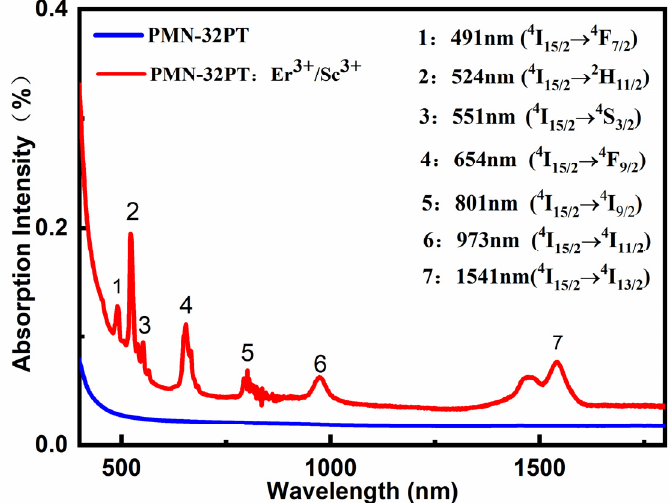
Figure 4. The absorption spectra of PMN-32PT and PMN-32PT:Er 3+ /Sc 3+ crystals.